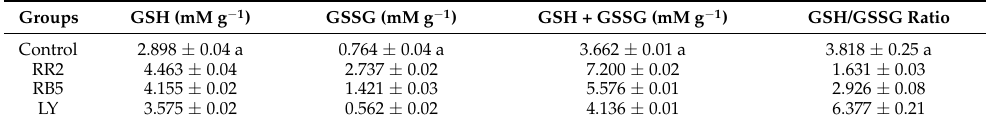
Table 3. Effect of different dyes administered at a concentration of 20 ppm on the glutathione level in P. caudatum